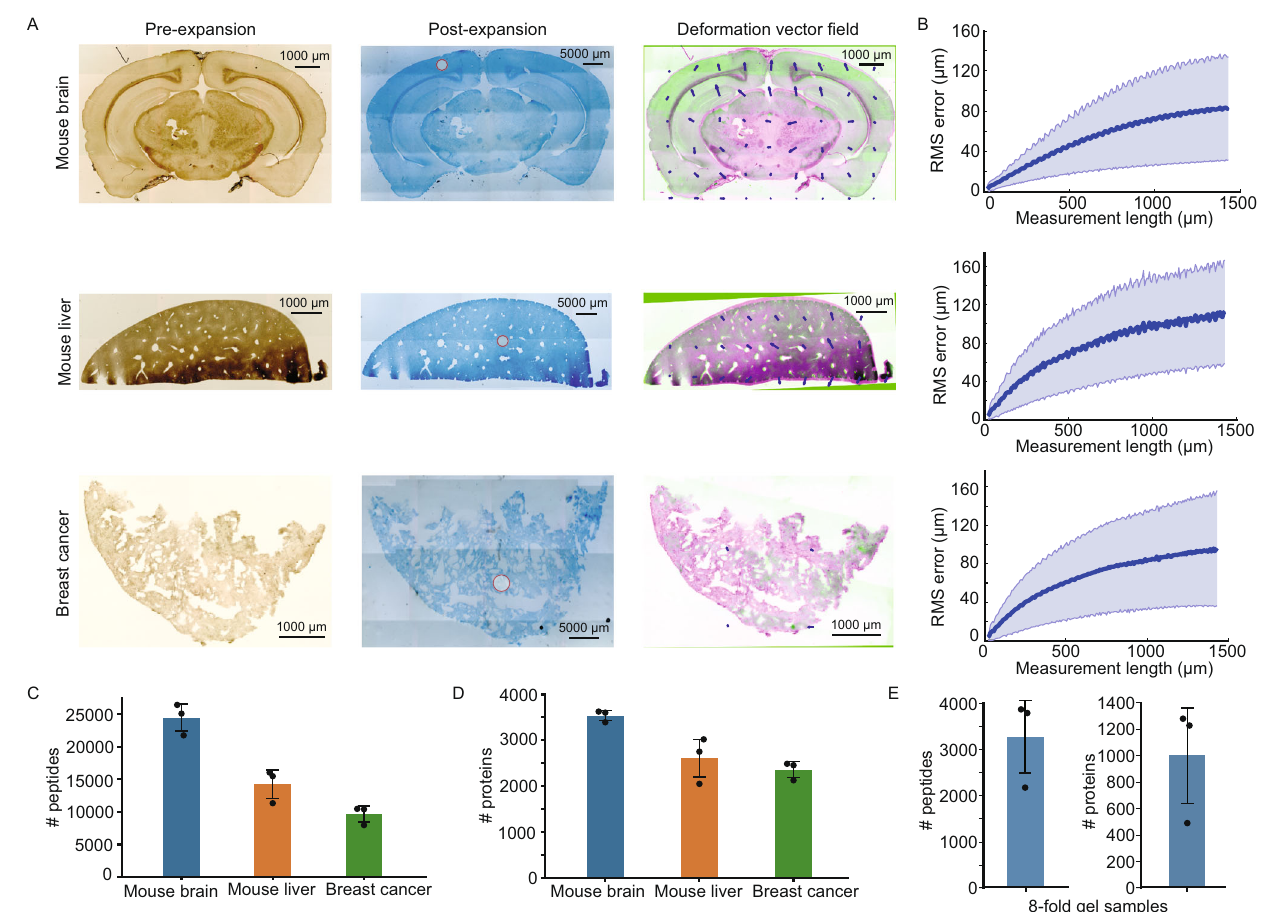
Fig. 3 | Validation of ProteomEx in different tissue types. A Representative bright- fi eld images of different tissue slices pre-expansion (left column) and post- expansion (middle column; Coomassie-stained) and overlay (right column) of pre- expansion image (green pseudo-color) and registered post-expansion image (magenta pseudo-color). Arrows represent the deformation vector fi eld ( n =3, 3, and 3 tissue slices from one mouse each; in the images of the expanded sample white circles represent the dissected area for peptide analysis shown in C . B The root-mean-square(RMS)measurementlengtherrorforpre-versuspost-expansion brainslice imagesforthe experimentsshownin A ( n =3, 3, and3 tissue slices from